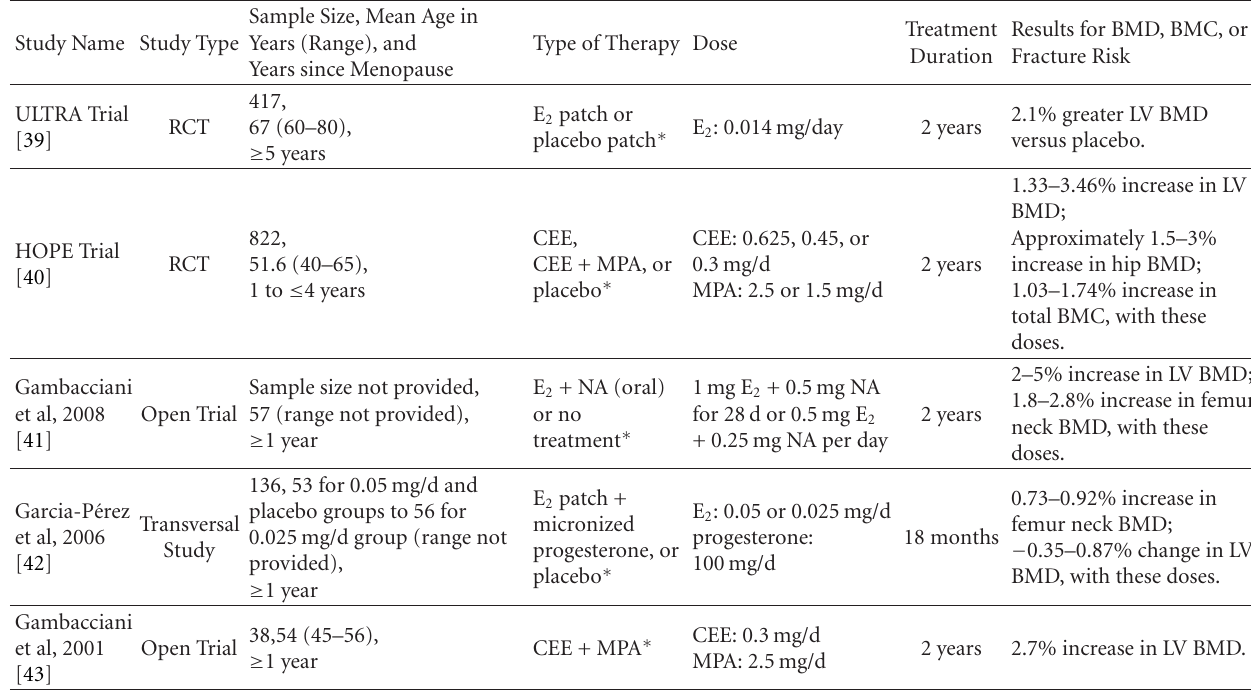
Table 2: Selected studies on the e ff ect of lower doses of hormone therapy on bone metabolism in postmenopausal